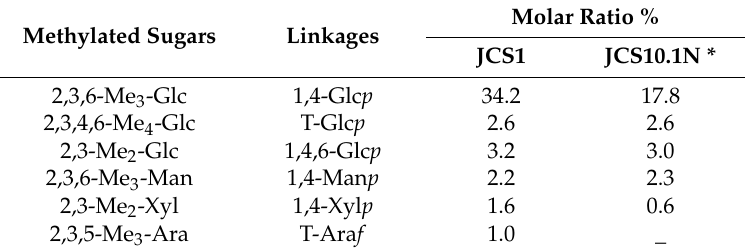
Table 1. Linkage analysis of JCS1 polysaccharide and its degraded product JCS10.1N using gas chromatography